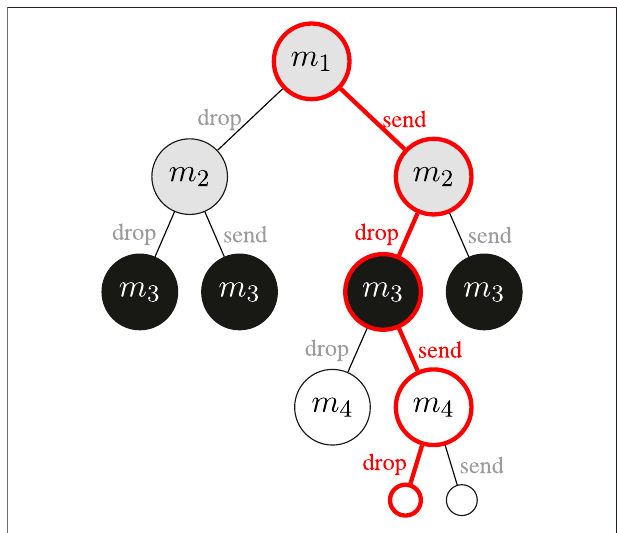
FIGURE 2 | Example of a tree constructed by MCTS. The black nodes represent the message to decide about. Grey nodes represent messages generated in the past that might have not been received yet. White nodes represent future